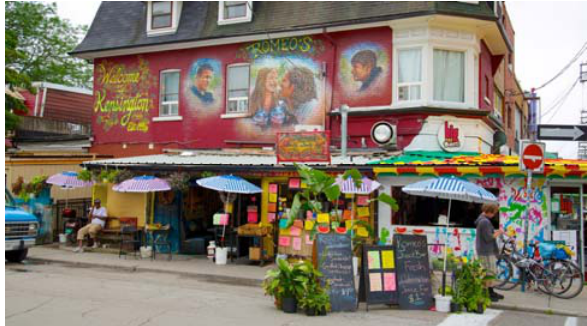
Figure 8: A Typical Street View at the Kensington Market